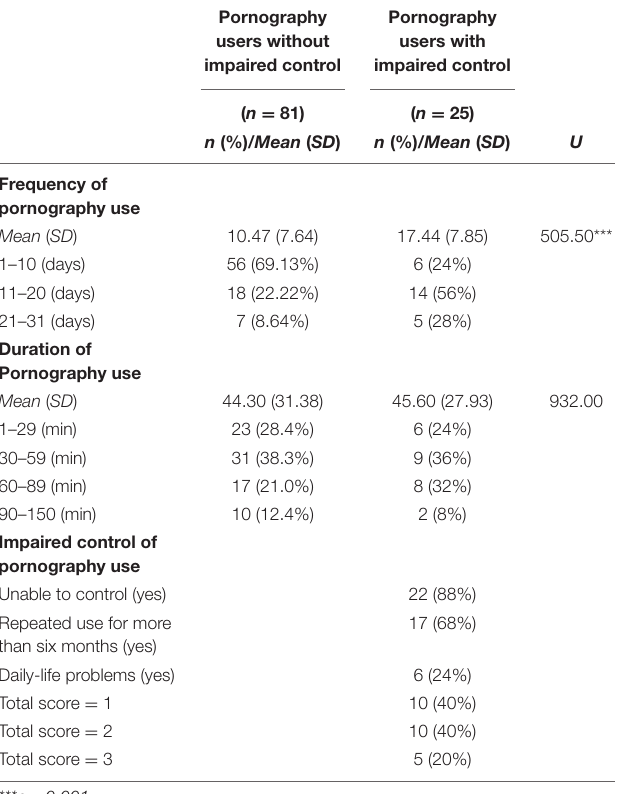
TABLE 1 | Comparison between pornography users without and with impaired control.